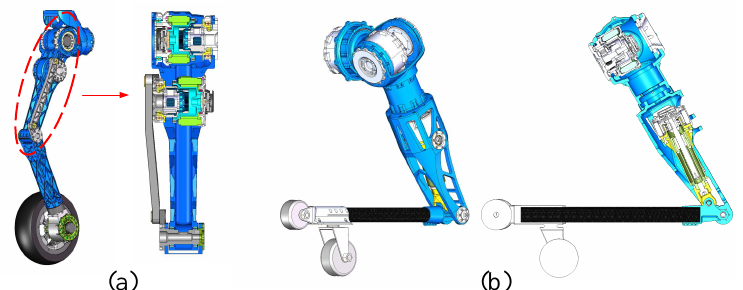
Figure 3. Three-dimensional (3D) structural model of the robot limbs. ( a ) Integrated structure of the robot leg and motors; ( b ) Structure of the robot arm.